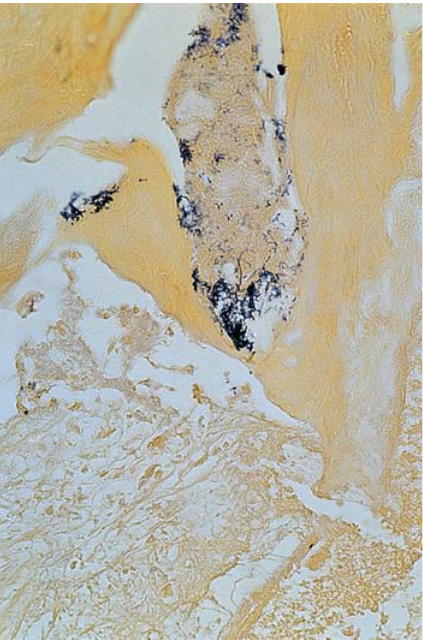
FIGURE 8- Apical region. Microorganisms in secondary canals, cementum lacunae and dentinal tubules. 125X